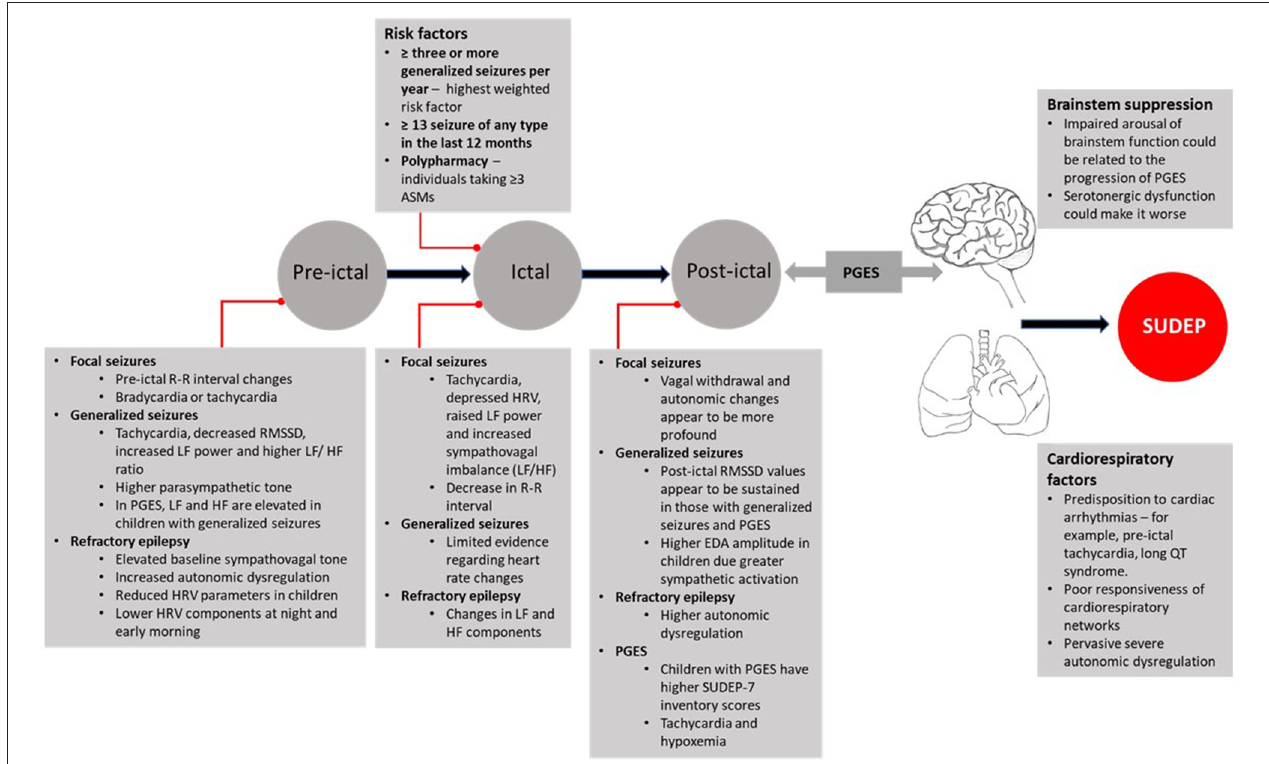
FIGURE 3 | Autonomic characteristics of pre-ictal, ictal, post-ictal states, and propensity to SUDEP. ASMs, Anti-Seizure Medications; EDA, Electrodermal Activity; HF, High Frequency; HRV, Heart Rate Variability; LF, Low Frequency; PGES, Post-ictal Generalized Electroencephalographic Suppression; QT, Q and T waves on ECG [electrocardiogram]; RMSSD, Root Mean Square of Successive Differences; R-R, Inter-Beat Interval; SUDEP-7, Sudden Unexpected Death in Epilepsy Risk Inventory.